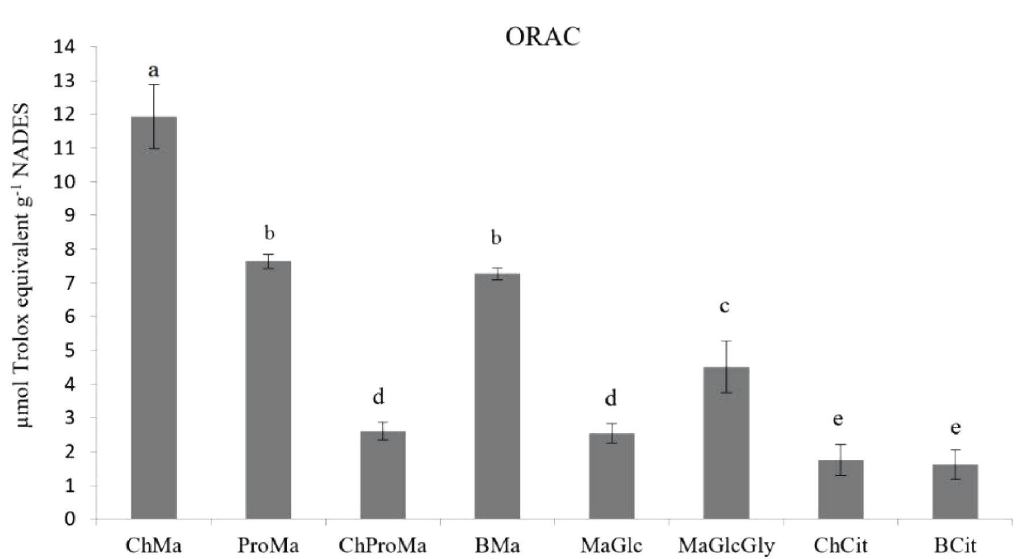
Fig. 9 – Oxygen radical absorbance capacity (ORAC) of prepared NADES. Results (mean values, n = 3, ± SD) are expressed as μmol TE g